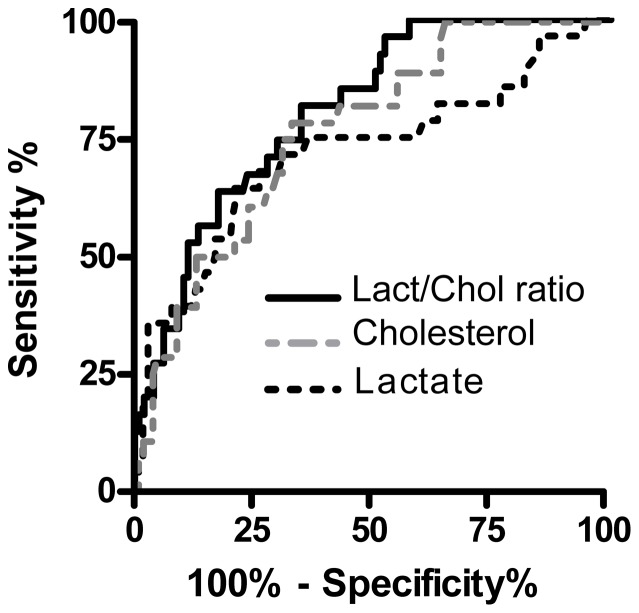
Receiver Operating Characteristic (ROC) curve analysis.ROC curves analysis of lactate, cholesterol and lactate to cholesterol ratio in relation with 30-day mortality in the training cohort.